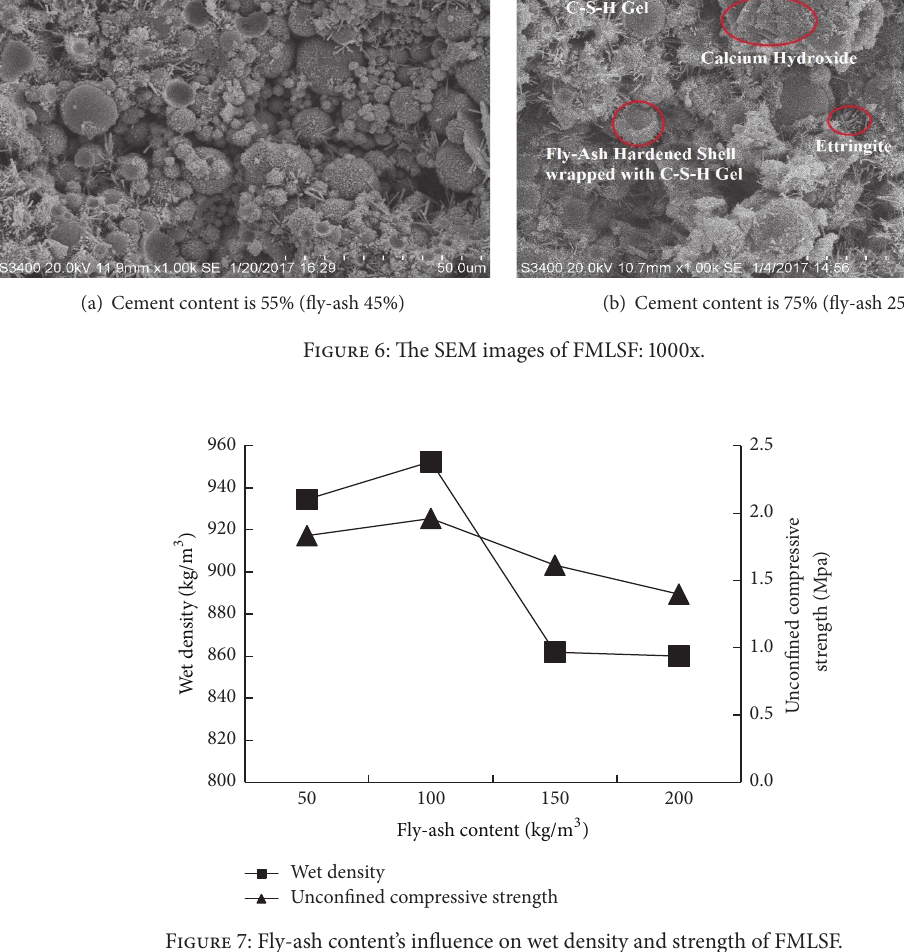
Figure 7: Fly-ash content’s influence on wet density and strength of